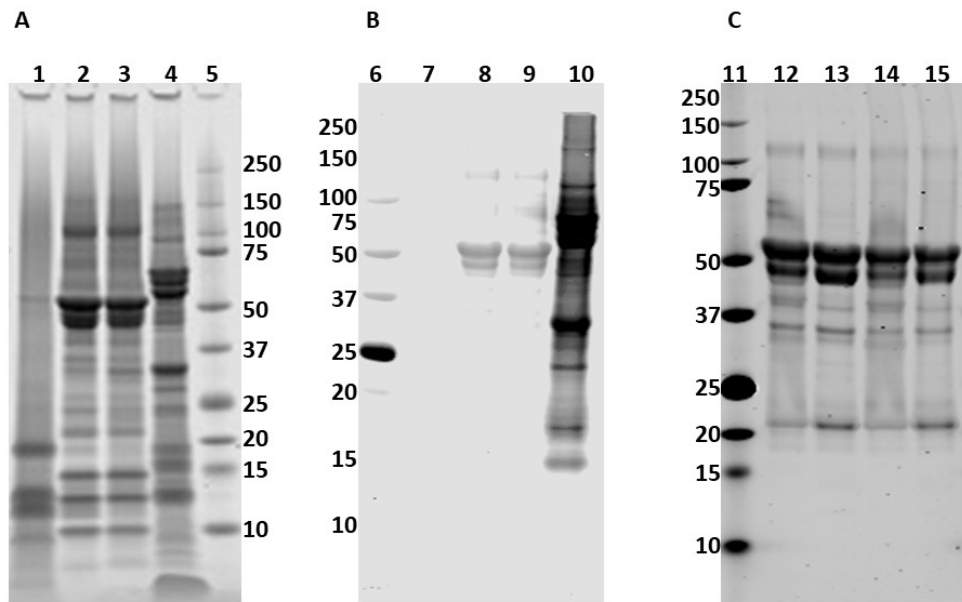
Figure 2. IgE from pooled peanut and tree nut sera recognize glandless cottonseed proteins. Three Gl cottonseed protein samples (Glw, Gla, & Gli) were compared to peanut extract by SDS-PAGE ( A ) and immunoblot with pooled sera from eight ELISA positive samples ( B ). IgE binding to Gla and Gli proteins was evaluated with and without DTT treatment ( C ). Glw protein is shown in lanes 1 and 7, Gla proteins in lanes 2, 8, 12, and 13, and Gli proteins in lanes 3, 9, 14, and 15, with peanut extract in lanes 4 and 10. DTT treated Gla and Gli treated proteins are in lanes 13 and 15. Molecular weight markers are shown in lanes 5, 6, and 11. Table 2. Proteins Matching Peptides from 51 and 49 kDa Bands. 51 kDa